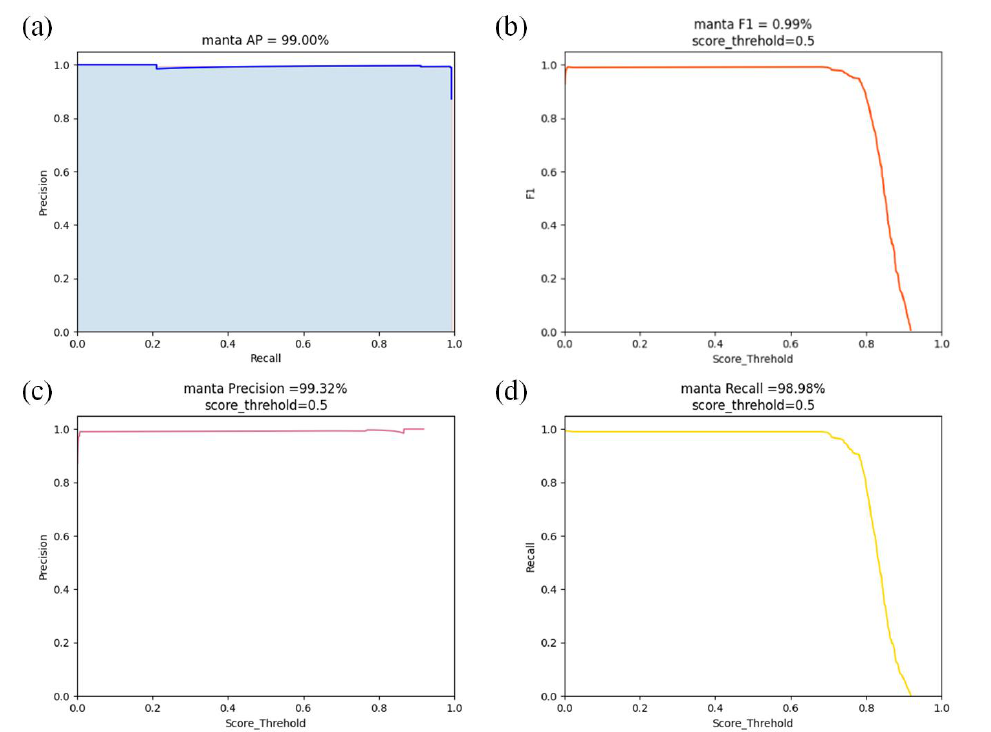
Figure 9. Plots of the prediction results of the network on the test set: ( a ) precision versus recall curve; ( b ) F1 value change; ( c ) precision change; ( d ) recall